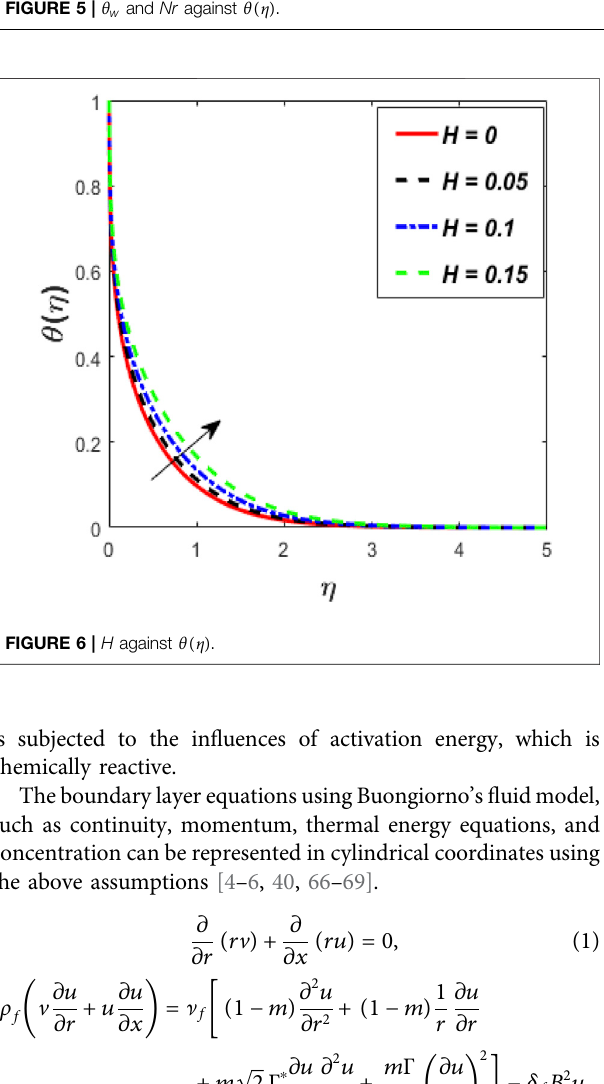
FIGURE 5 | θ w and Nr against θ ( η ) .